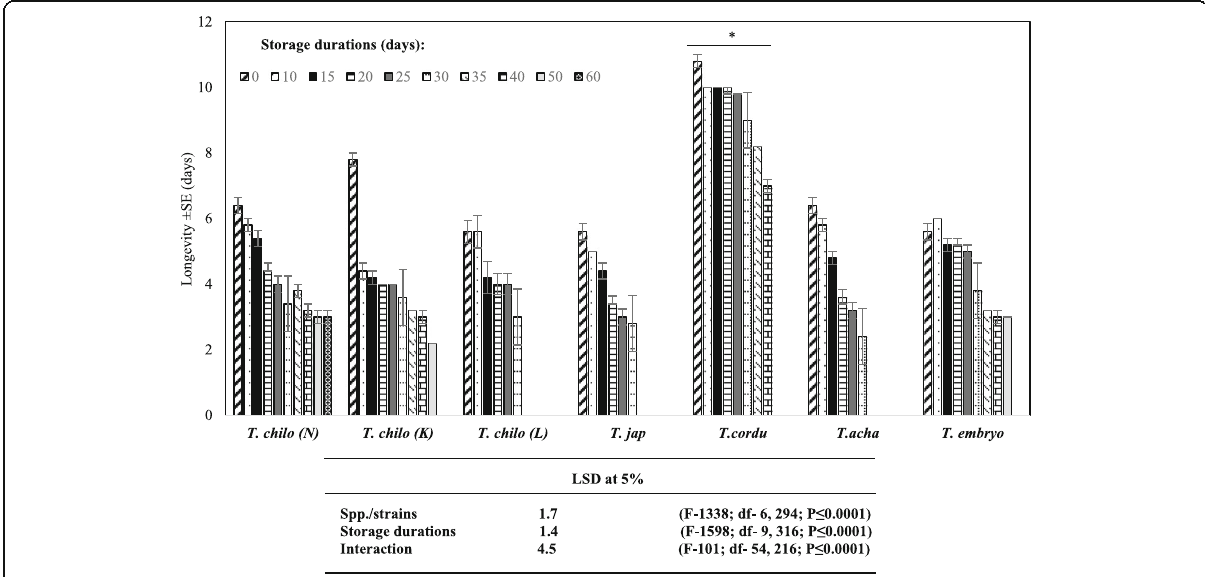
Fig. 2 Longevity of different spp./strains of Trichogramma after their pupal stage storage on Corcyra cephalonica eggs at 10 °C (L:D 8:16, RH 70 ± 10%). Control treatment (0 days): un-stored batch of Trichogramma pupae. T. chilo (N) , Trichogramma chilonis Nilgiris; T. chilo (K) , T. chilonis Kodaikanal; T. chilo (L) , T. chilonis Lab; T. jap , T. japonicum ; T. cordu , T. cordubensis ; T. acha , T. achaeae ; T. embryo , T. embryophagum